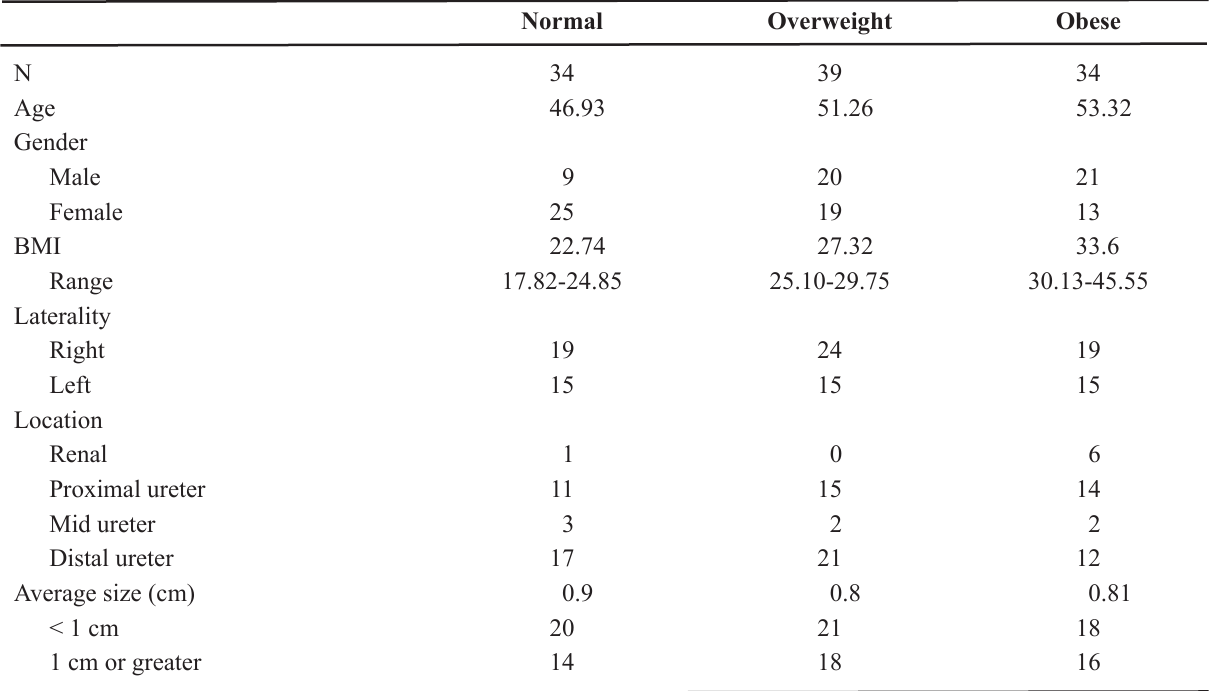
Table 2 – Patient